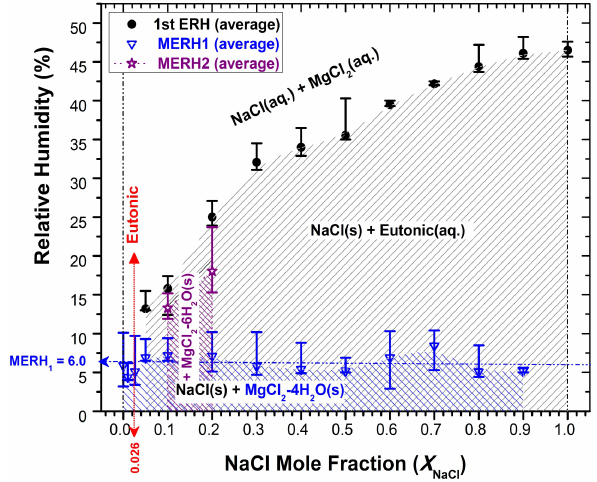
Figure 8. Measured first ERH values (closed black circles) and sec- (cid:113) ond ERH values (open blue triangles – MERH 1 for MgCl 2 4H 2 O crystallization in type A or B particles – and open purple stars – (cid:113) MERH 2 for MgCl 2 6H 2 O crystallization in type C particles) as a function of the mole fraction of NaCl in NaCl–MgCl 2 mixture par- ticles. The phase notations shown in parentheses are s = solid and aq =